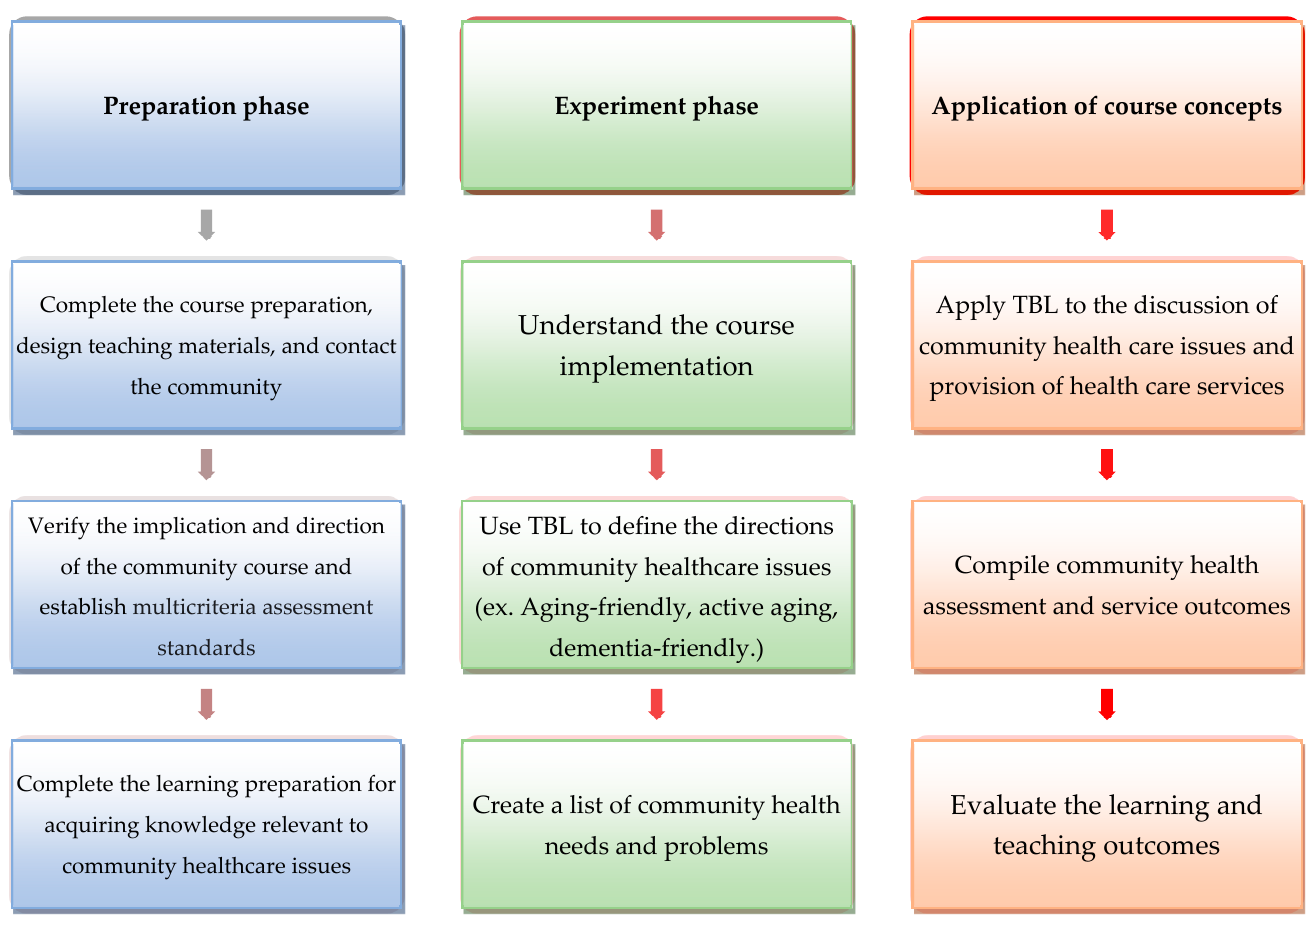
Figure 2. TBL phases.